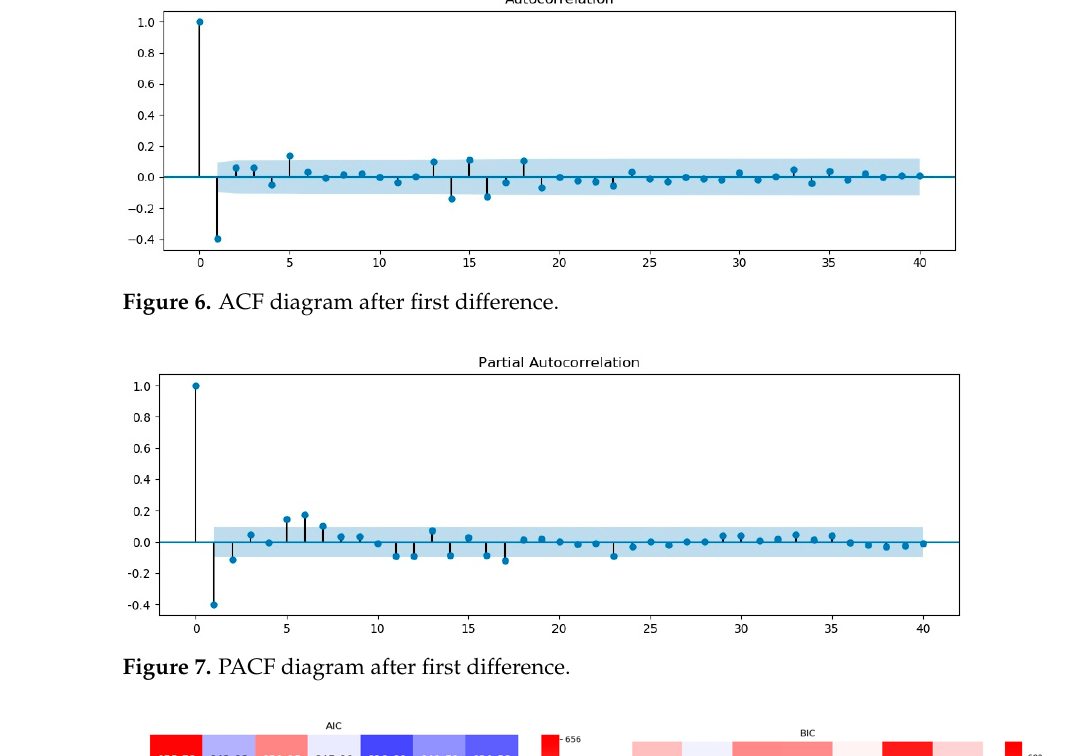
and ( c ) HQIC value.